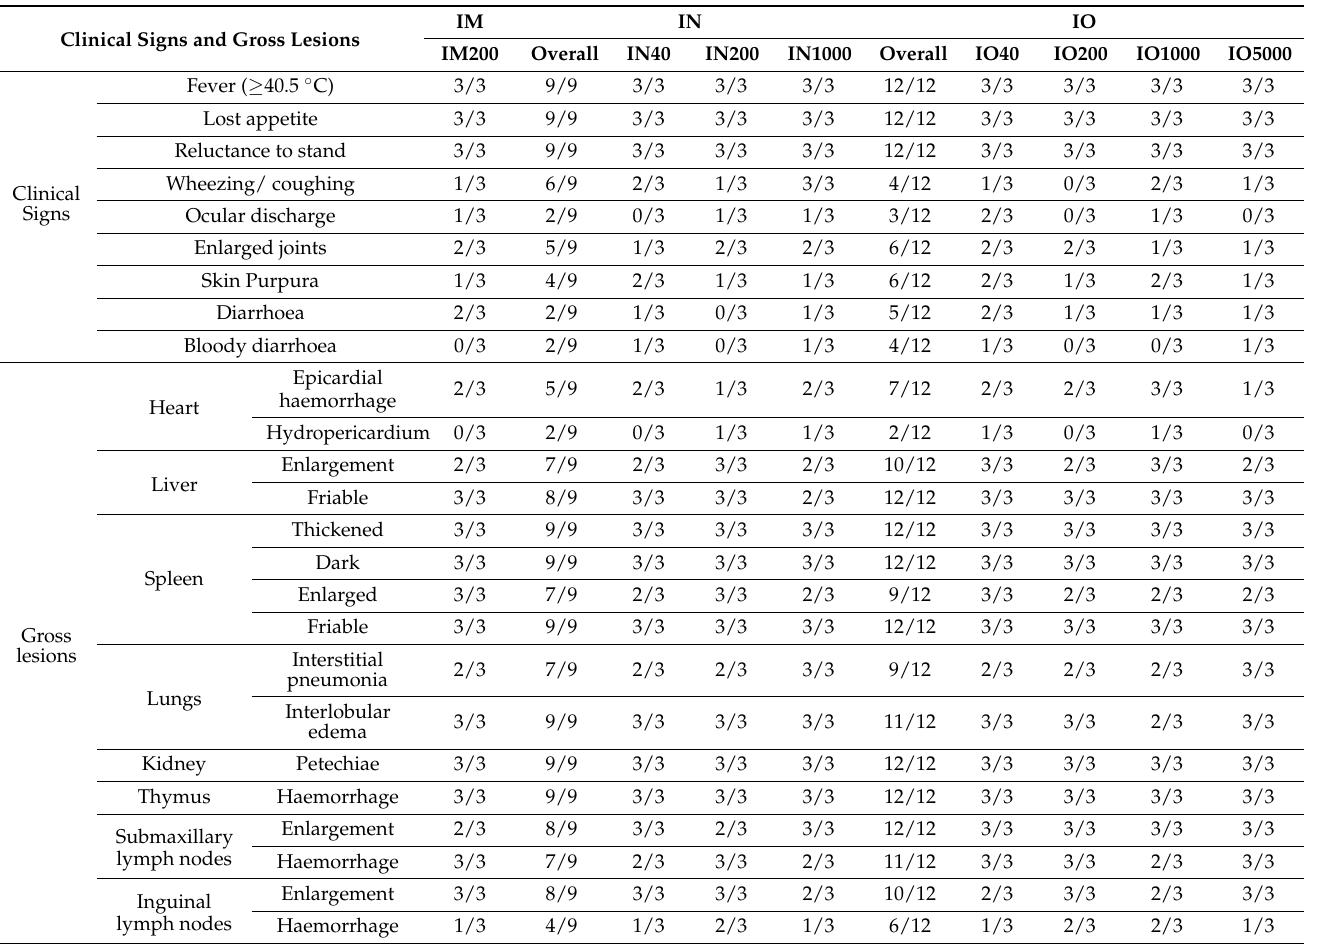
Table 3. Summary of clinical signs and gross lesions in pigs inoculated with different doses of ASFV SY18 at different modes of